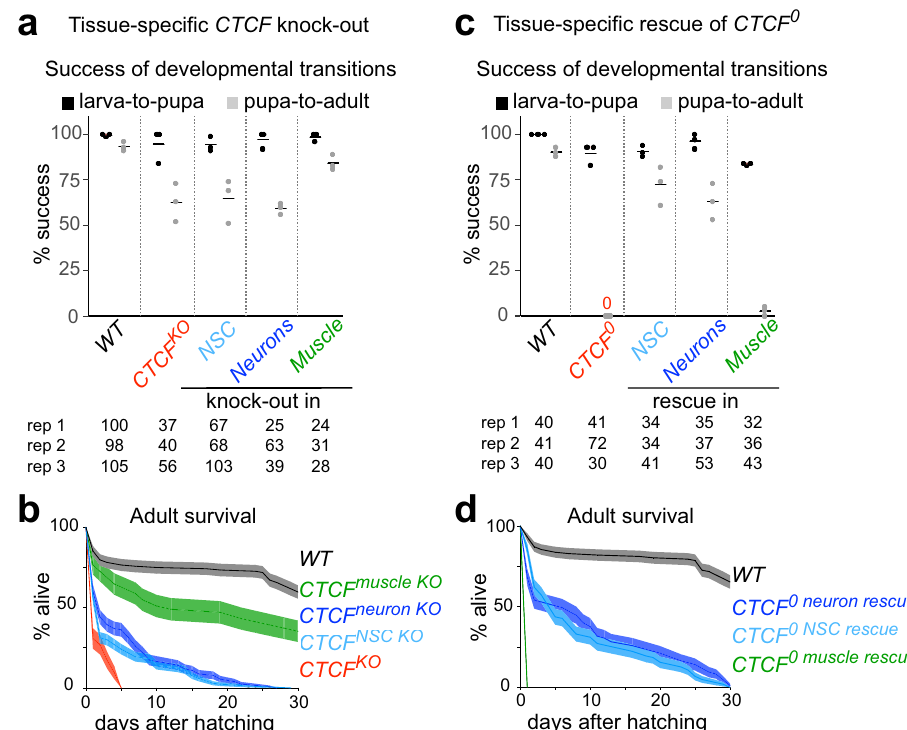
Fig. 1 CTCF expression in neural stem cells or neurons is essential for Drosophila viability. a Percentages (in y) of wildtype (WT), CTCF KO and animals lacking CTCF in neural stem cells (NSCs), neurons or muscle that successfully transition from third instar larva to pupa (black) and from pupa to adult (gray) in n = 3 biological replicates (rep 1 – 3), each containing the indicated number of animals per genotype. Horizontal lines show means. ( b ) Percentage of live adults of the same genotypes up to 30 days after pupal hatching. 40 animals of each genotype were analyzed in triplicate; dark lines show mean and shading shows ±standard deviation. c Same as ( a ) but for WT, CTCF 0 and animals with CTCF expression restricted to NSCs, neurons or muscle. d Same as ( b ) but for genotypes indicated in ( c